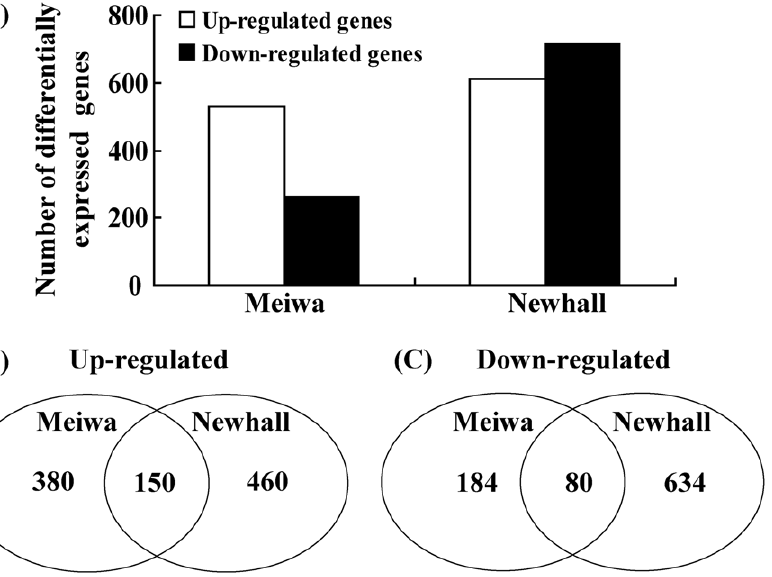
Figure 2. Number of differentially expressed genes in ‘Meiwa’ and ‘Newhall’ after statistical analysis. (A) Number of significantly upregulated and downregulated genes in ‘Meiwa’ and ‘Newhall’. (B–C) Venn diagram shows the number of upregulated (B) and downregulated (C) genes that are expressed in common or in special between ‘Meiwa’ and ‘Newhall’.